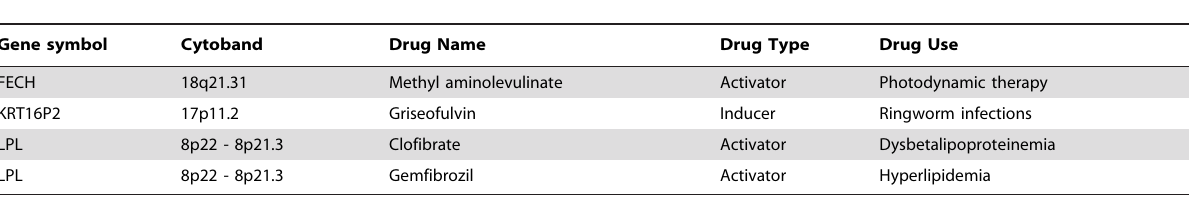
Table 6. Approved agonist, activator and inducer drugs targeted against genes in deleted regions in